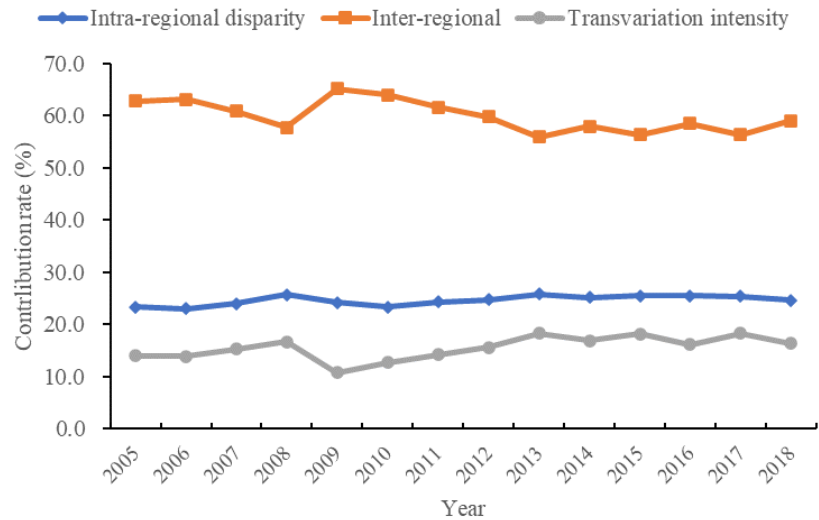
Figure 4. Contribution rate in industrial green technology innovation efficiency (GTIE) from 2005 to 2018.